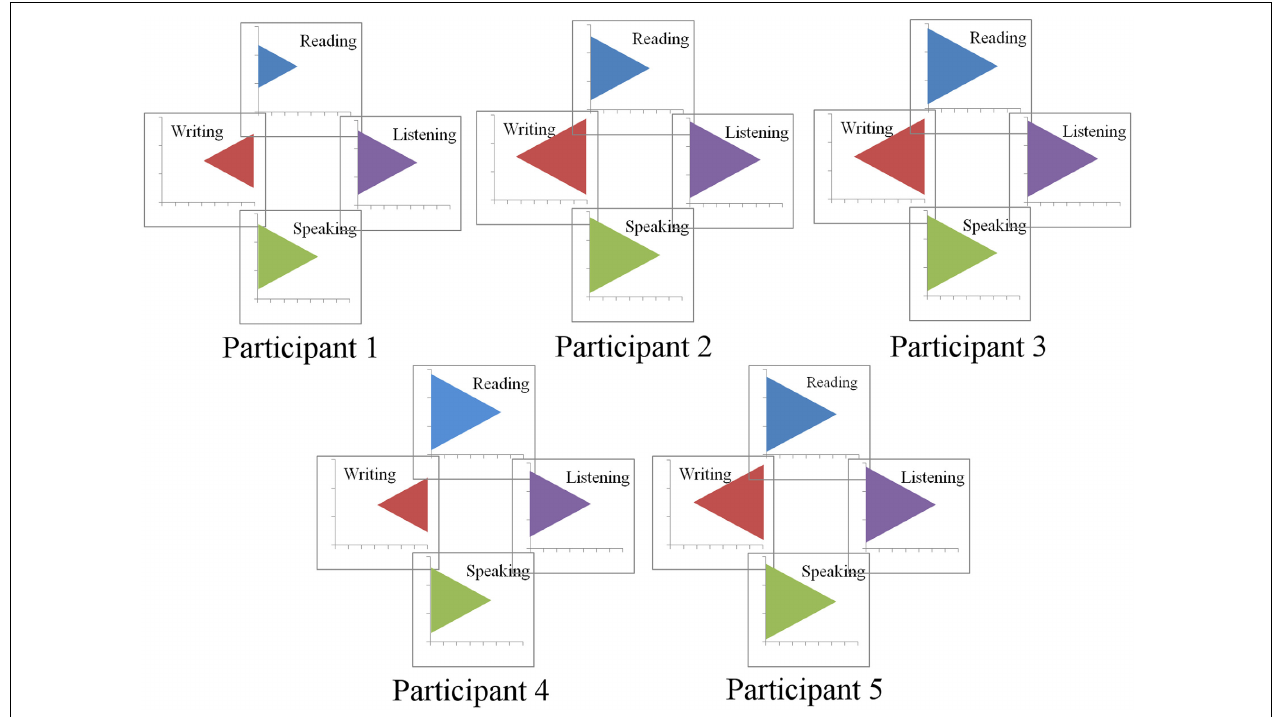
FIGURE 7 | Recoding of bar graph into relative triangle sizes. This is the second step in the development of visual participant profiles.